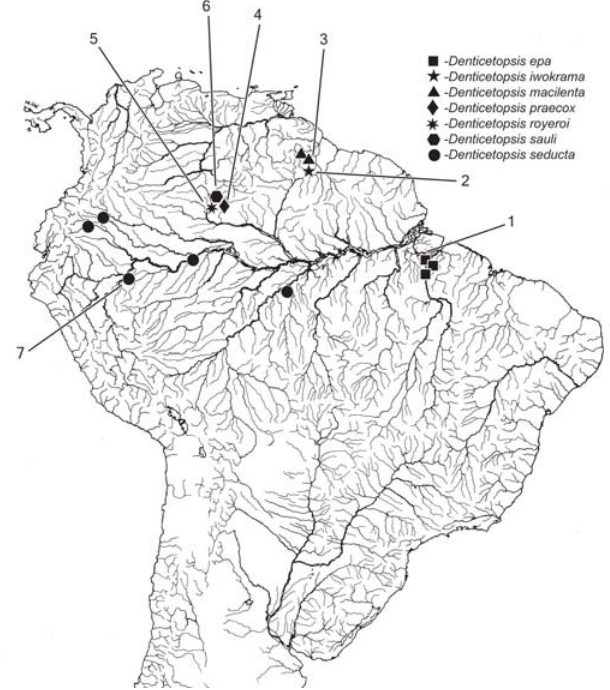
Fig. 46. Map of central and northern South America showing geographic distribution of Denticetopsis epa (1 = holotype locality), Denticetopsis iwokrama (2 = holotype locality), Denticetopsis macilenta (3 = holotype locality of Hemicetopsis macilenta ), Denticetopsis praecox (4 = holo- type locality), Denticetopsis royeroi (5 = holotype locality), Denticetopsis sauli (6 = holotype locality), and Denticetopsis seducta (7 = holotype locality) (some symbols represent more that one locality and/or lot of